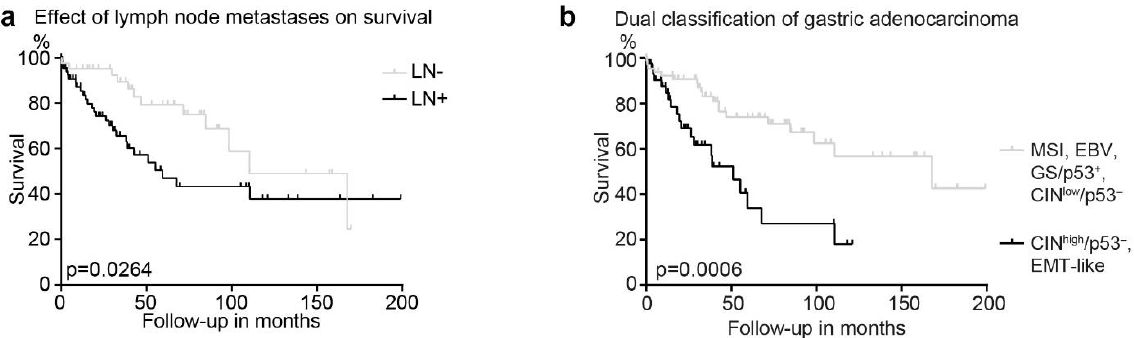
Figure 6. Survival analysis in 115 patients with GAC. ( a ) Impact of the presence of lymph node metastasis in the total cohort shows an inferior outcome in patients with lymph node metastasis. ( b ) Grouping the subtypes of GAC into high and low risk tumors: Low risk: MSI, EBV, and CIN low /p53 − ; high risk: CIN high /p53 − and EMT-like.